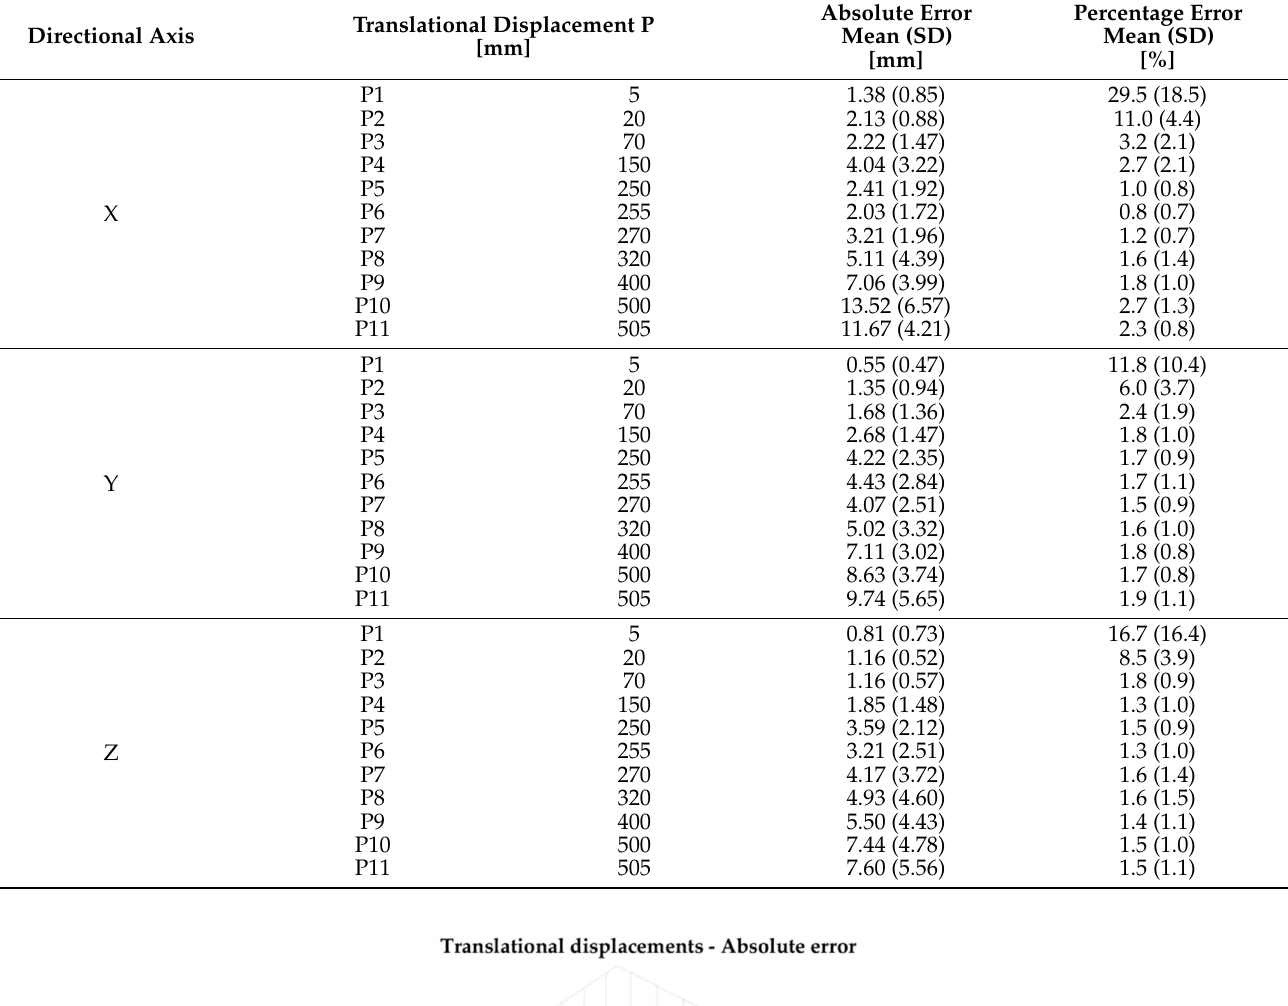
Table 2. Errors for all the translational displacements along the x-, y-, and z- directions. Directional Axis